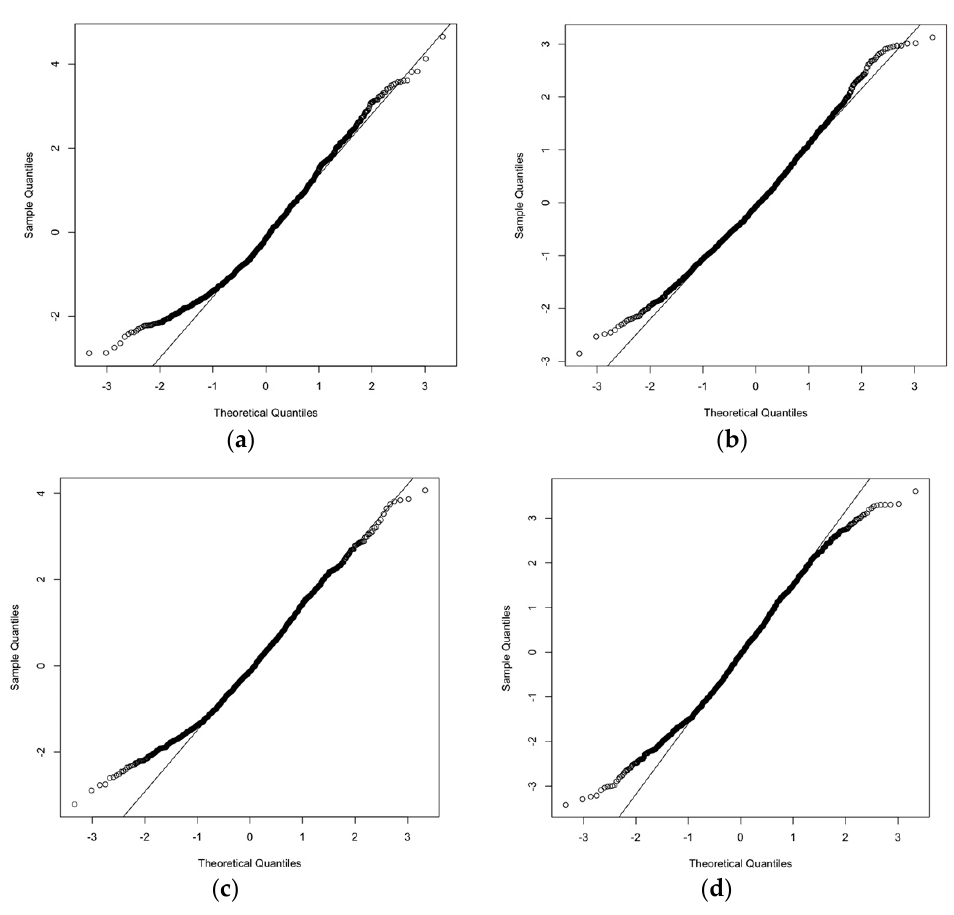
Figure 2. ( a ) Normal QQ ‐ plot of residuals for the dependent variable Depression; ( b ) normal QQ ‐ plot of residuals for the dependent variable Unworthiness; ( c ) normal QQ ‐ plot of residuals for the dependent variable Alienation; ( d ) normal QQ ‐ plot of residuals for the variable Helplessness. Table 3. Sample correlations between the dependent variables.